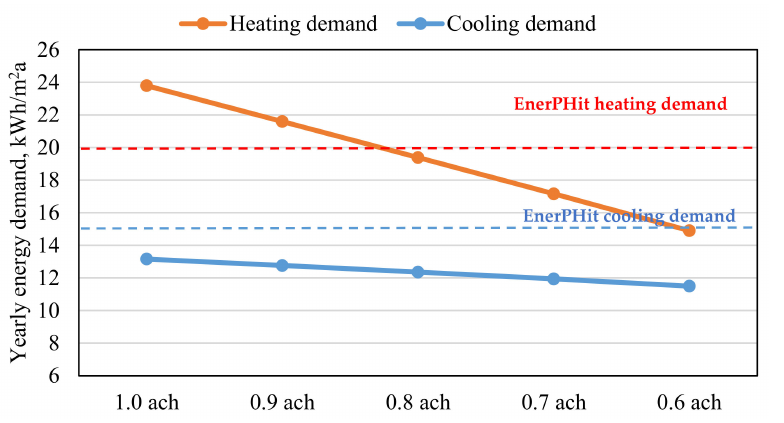
Figure 7. Parametric analysis for airtightness towards the building’s heating and cooling